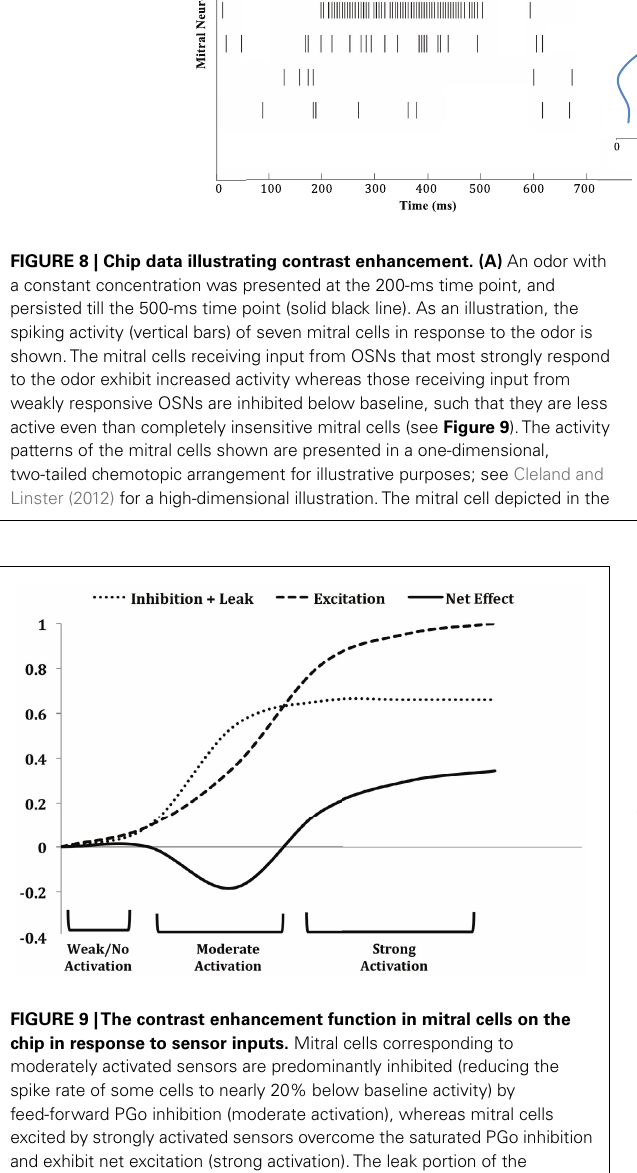
FIGURE 9 |The contrast enhancement function in mitral cells on the chip in response to sensor inputs. Mitral cells corresponding to moderately activated sensors are predominantly inhibited (reducing the spike rate of some cells to nearly 20% below baseline activity) by feed-forward PGo inhibition (moderate activation), whereas mitral cells excited by strongly activated sensors overcome the saturated PGo inhibition and exhibit net excitation (strong activation).The leak portion of the “inhibition + leak” curve represents charge leakage out of the cell between successive excitatory spikes received from OSN inputs, and therefore is inversely related to the activity of the OSNs. For strongly activated sensors, the excitation delivered to the mitral cells is of sufficiently high frequency to overcome the combined effects of PGo inhibition and the leak current. Figure adapted from Cleland and Sethupathy